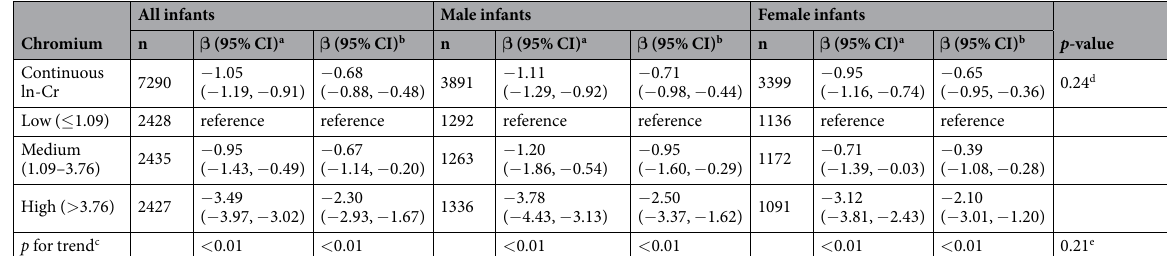
Table 2. Multivariable linear regression analyses of the association between maternal urinary chromium ( μ g/g cr) and gestational age (days). CI = confidence interval. a Unadjusted confounders. b Adjusted for maternal age, education, BMI, parity, pregnancy-induced hypertension and other metals. c p -values for trend across tertiles of